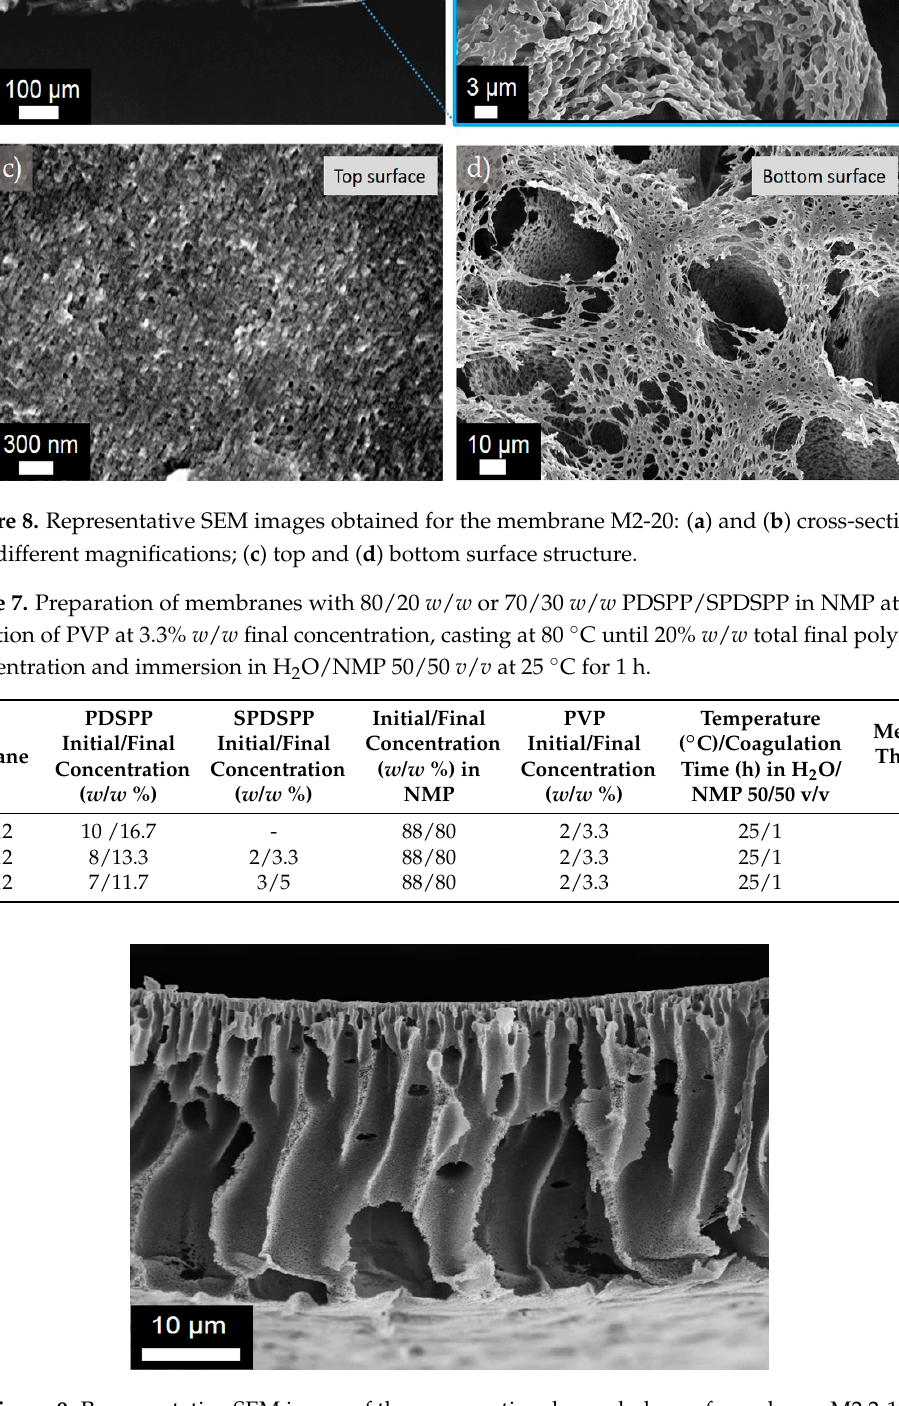
Figure 9. Representative SEM image of the cross-sectional morphology of membrane M2,2-12.